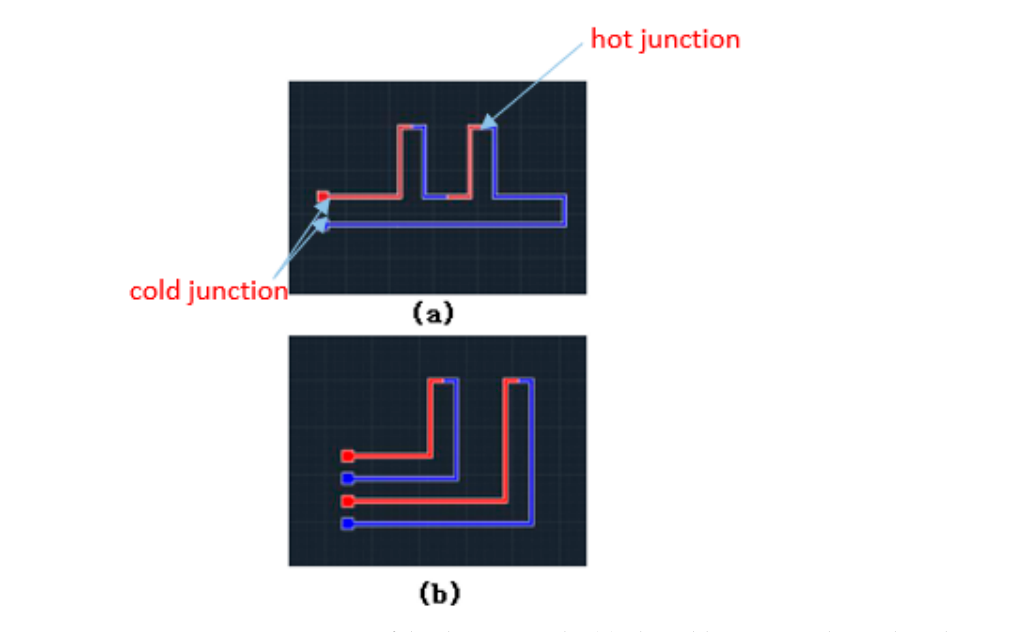
Figure 6. Two structures of the thermocouple. ( a ) The cold junction is located on the center part of the polyimide film; ( b ) the cold junction was led out with extension wire to avoid influence from the skin.